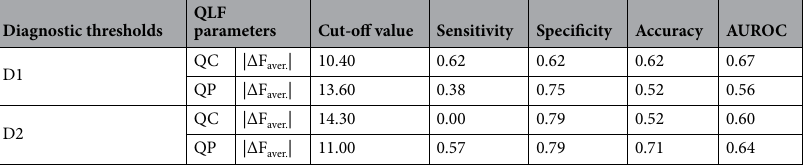
Table 4. Cut-off values and validity of QLF parameters for detecting proximal dental caries. Quantitative light-induced fluorescence (QLF); Qraycam Pro® (QP); Qraypen C®